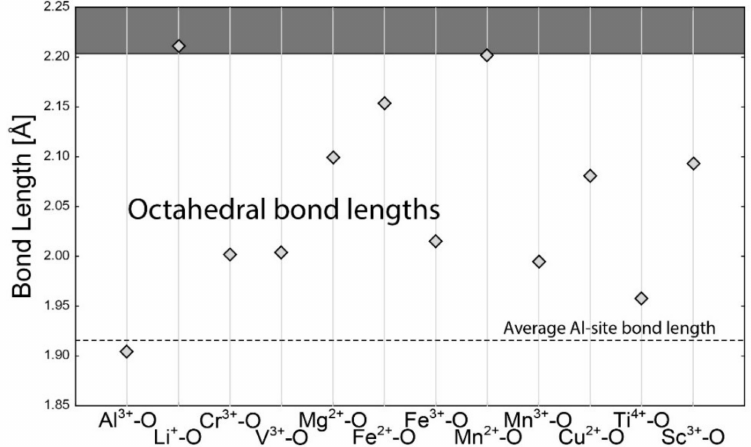
Figure 3. Calculated bond lengths for each bond in the octahedral coordination of cation (Al site). The horizontal dashed line is for average empirical bond length. The horizontal full line is the 15% limit for free substitution. The area of free substitution is white. The substitution is significantly limited for cations in the grey